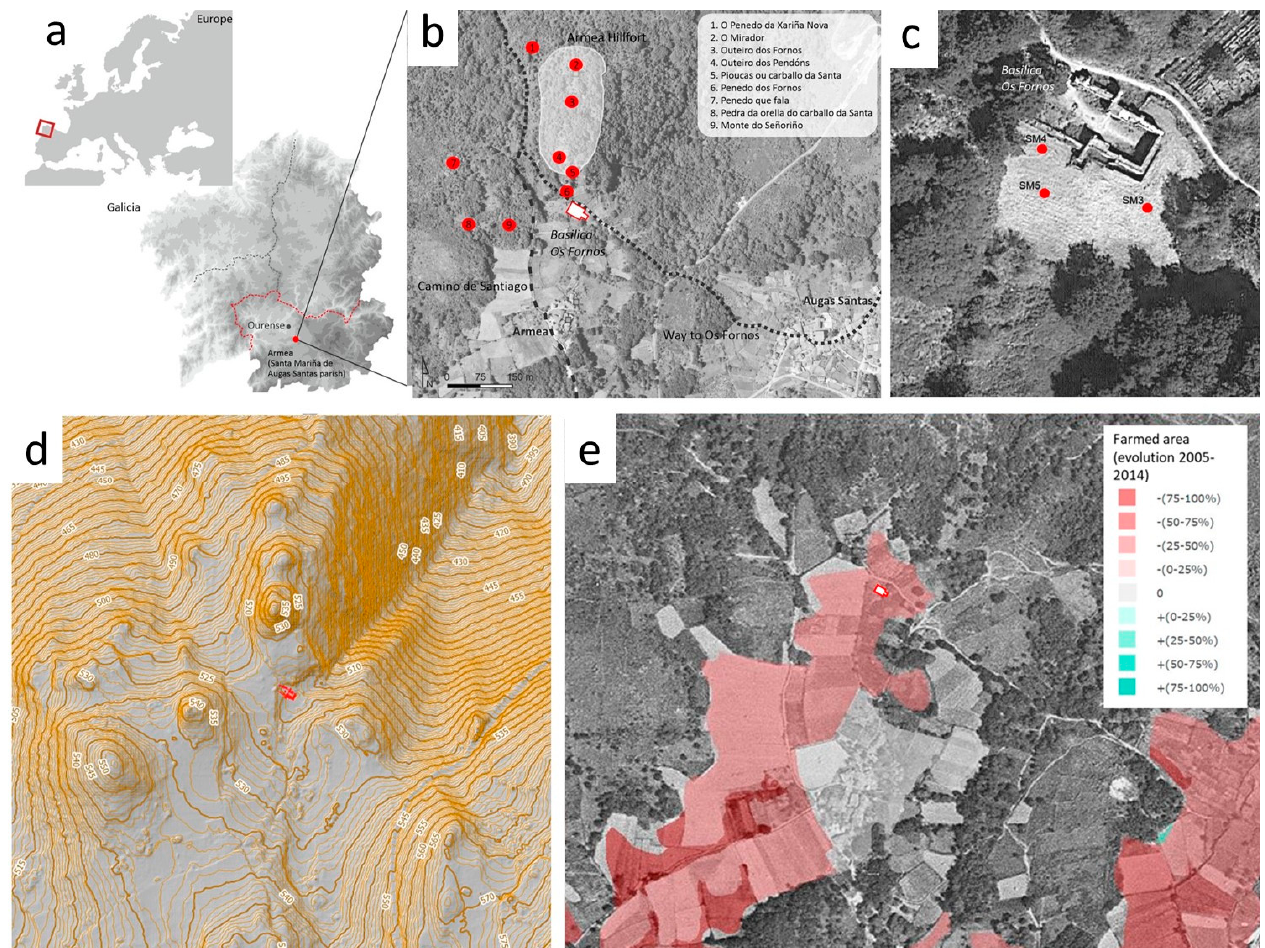
Figure 1. ( a ) Geographical location of Santa Mariña; ( b ) orthoimage of the site, indicating the location of the Basilica and other symbolic landmarks related to Santa Mariña myth; ( c ) position of the sampled cores; the SM3 core was selected for geochemical study because of its higher potential for storing paleoenvironmental and geoarchaeological information; ( d ) topographic setting of Santa Mariña and surroundings. Present day land use is still a combination of agricultural, forestry, habitational, and worship spaces, although the farmed area has decreased during the last decades, in favour of forest exploitation or secondary deciduous forest communities. ( e ) shows the evolution of the farmed land between 2005 and 2014 (shaded area) with the background photograph showing the extension of cultivated land in the 1950s (data from the Spanish system of land use observation—SIOSE 2014—and published online by Xunta de Galicia: http://mapas.xunta.gal/visores/ocupaciondosolo/ accessed 13 September 2021).